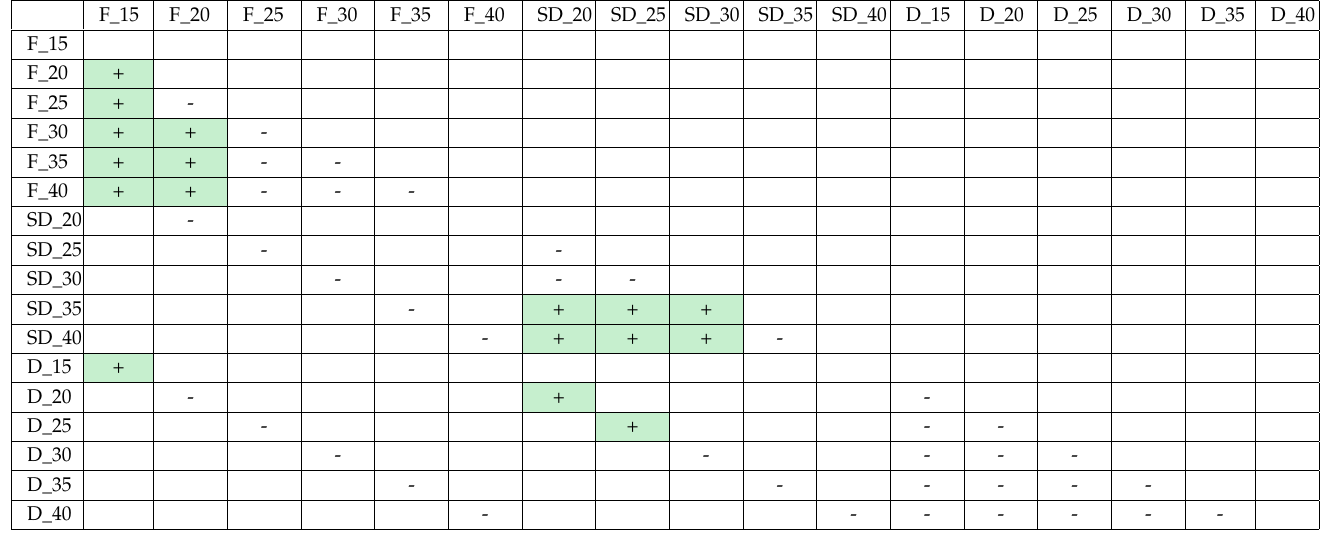
Table A4. WHC (mass based) significance − 1 kPa, plus (+) and green background indicates significant differences, minus (-) indicates statistically insignificant